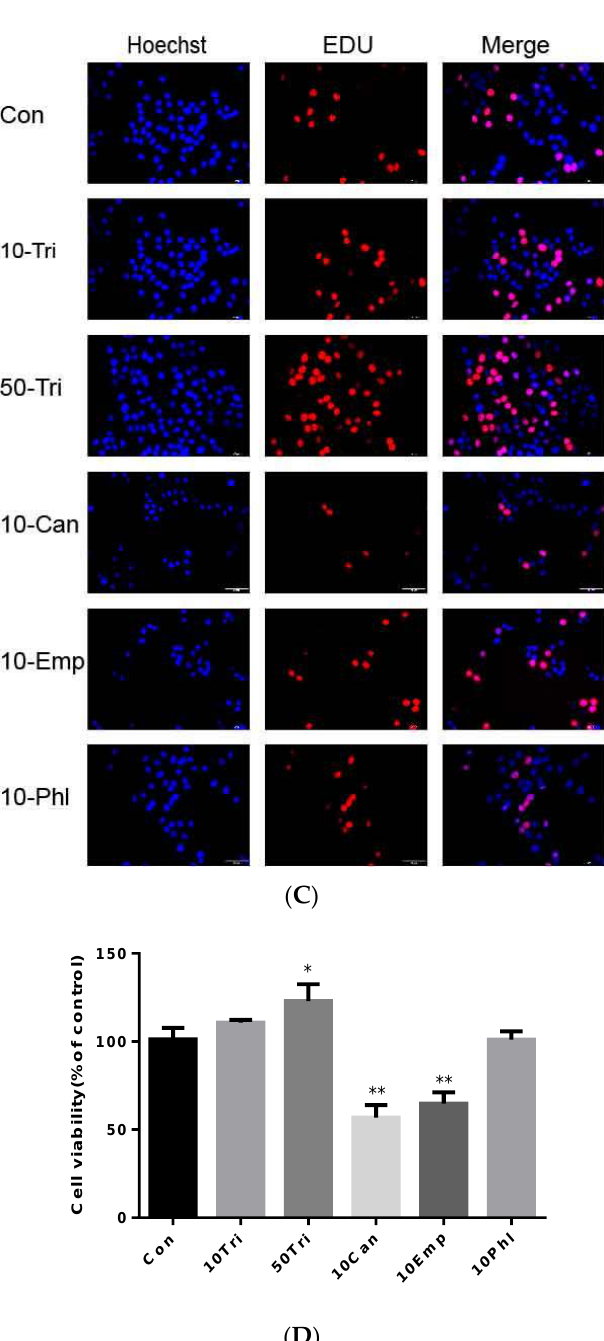
Figure 3. Effects of trilobatin, canagliflozin, empagliflozin and phloridzin on the cell cycle and DNA replication in HepG2 cells. A: After HepG2 cells were incubated with 50 μ M trilobatin (50Tri), 100 μ M trilobatin (100Tri), 10 μ M canagliflozin (10Can), 10 μ M empagliflozin (10Emp) and 10 μ M phloridzin (10Phl) for 24 h, the cells were collected and cell cycle was measured by flow cytometry. B : The statistical results of flow cytometry assay for cell cycle after treated with rilobatin, canagliflozin, empagliflozin and phloridzin respectively. C : Proliferating HepG2 cells were labeled with EDU, the Click-it reaction showed EDU staining (red), and cell nuclei were stained with Hoechst 33342 (blue). The images are representative of the obtained results (Scale bar = 100 nM). D : The percentage of EDU-positive HepG2 cells was calculated from three random fields, * p < 0.05, ** p < 0.01 vs. control (Con).